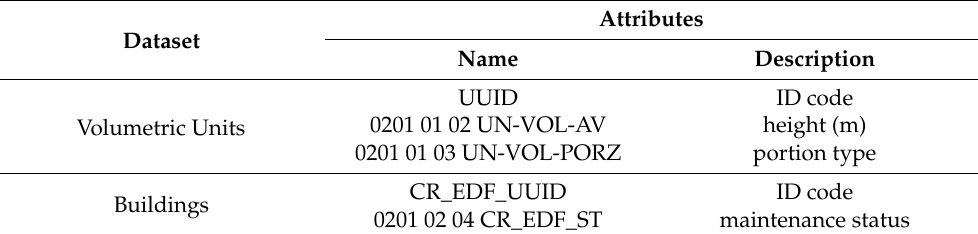
Figure 1. Flowchart of the pre-processing procedure. Table 2. Adopted spatial datasets and used Attributes from the Topographic